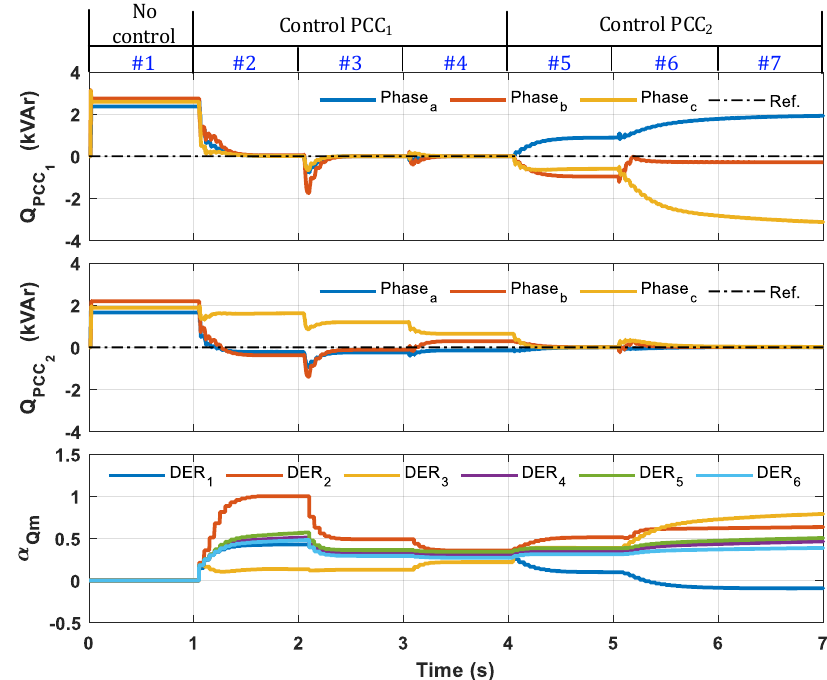
Figure 8. Reactive power in PCCs and scalar coefficients (𝛼 𝑄𝑚 ) for MPBC.